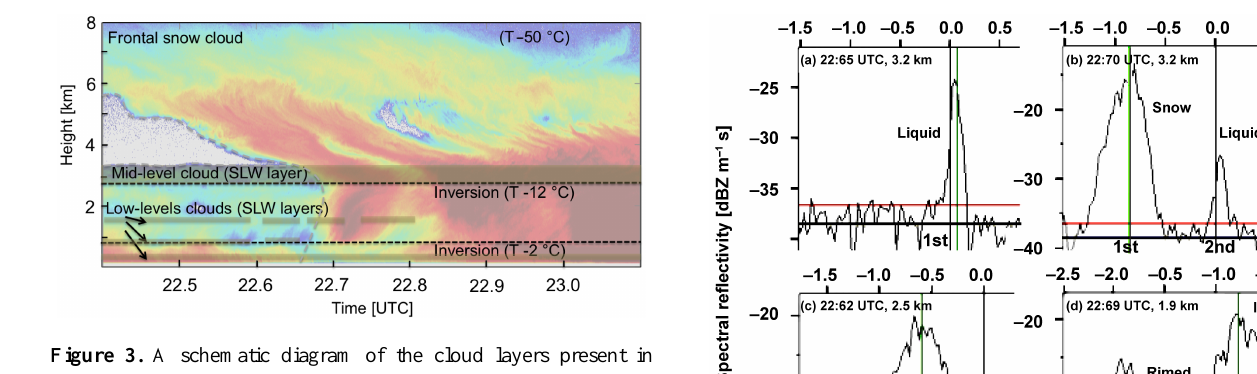
SNEX period but unfortunately, for all other events, only merged peaks were observed in the KAZR Doppler